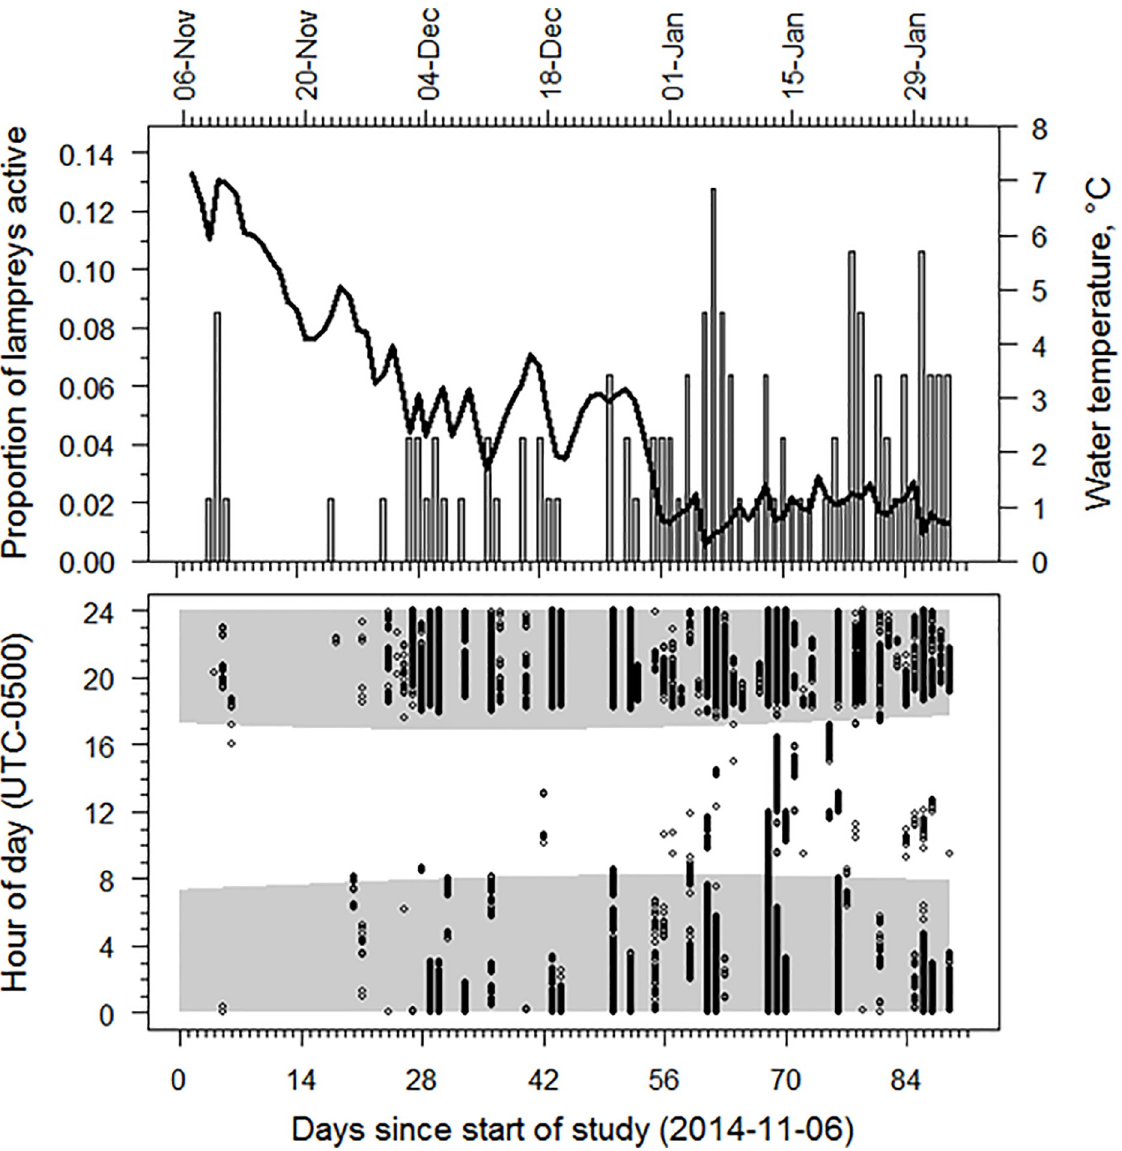
Fig 5. Study III: Downstream movement activity by juvenile sea lamprey in an artificial stream. Proportion of newly metamorphosed juvenile sea lamprey that moved downstream at least once (vertical bars) each day, with mean daily water temperature (black line; secondary y-axis), in an artificial stream November 6, 2014 –February 2, 2015 (Panel A); timing of diel movement events during the 91-day observation period (Panel B). Shading in indicates period between sunrise and